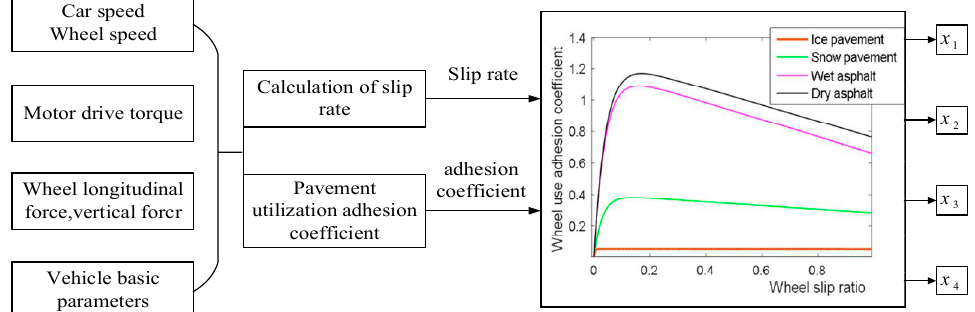
Figure 6. Fuzzy controller for road surface